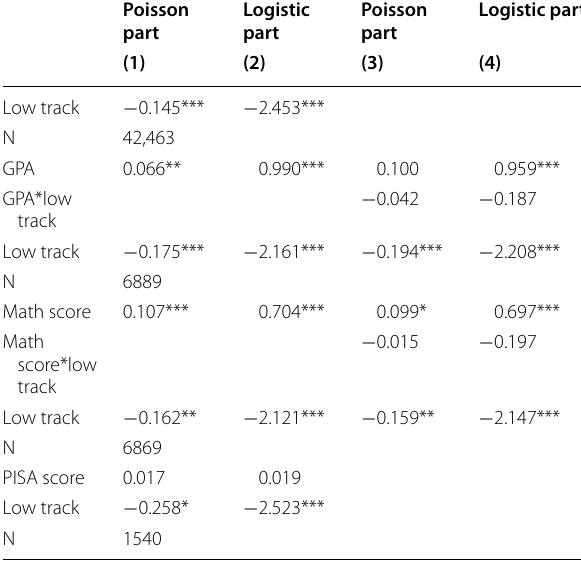
Table 7 The effect of lower secondary school track and grades on the accumulation of years of dual VET within a given ISCO, selected